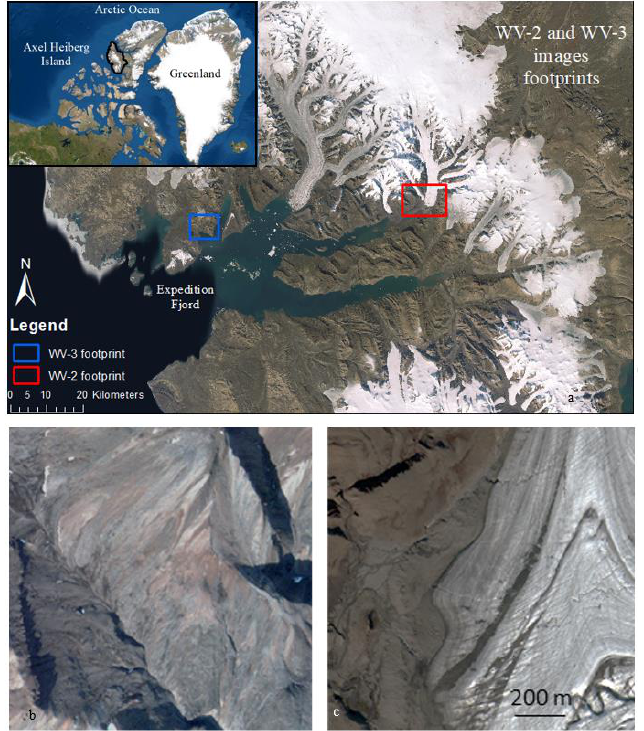
Figure 3. Map ( a ) and examples of satellite imagery from WV-2 ( b ) and WV-3 ( c ). Service Layer Credits: Esri, Maxar, GeoEye, Earth star Geographics, CNES/Airbus DS, USDA, USGS, AeroGRID, IGN, and the GIS User Community.